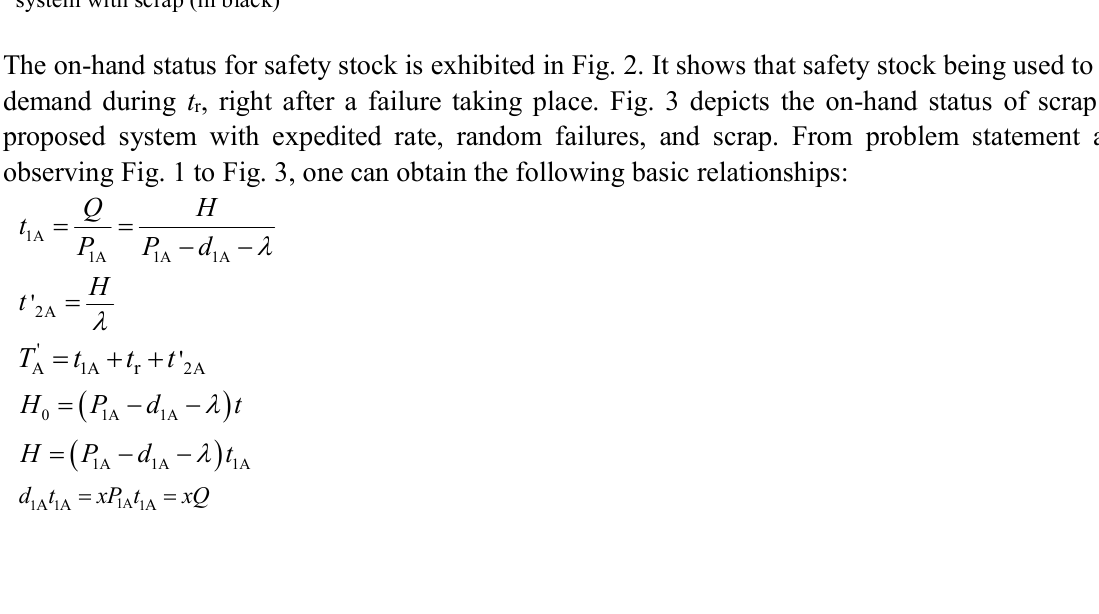
Fig. 1 . On-hand stock status in the proposed system with expedited rate, random failures, and scrap (in green) as compared to that of a fabrication system with scrap (in black)